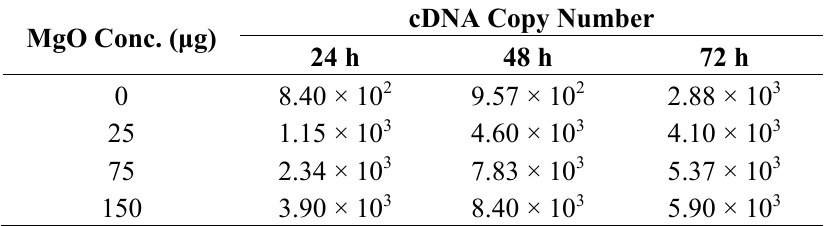
Table 1. The expressed GST gene number with variation in MgO concentration and incubation time.